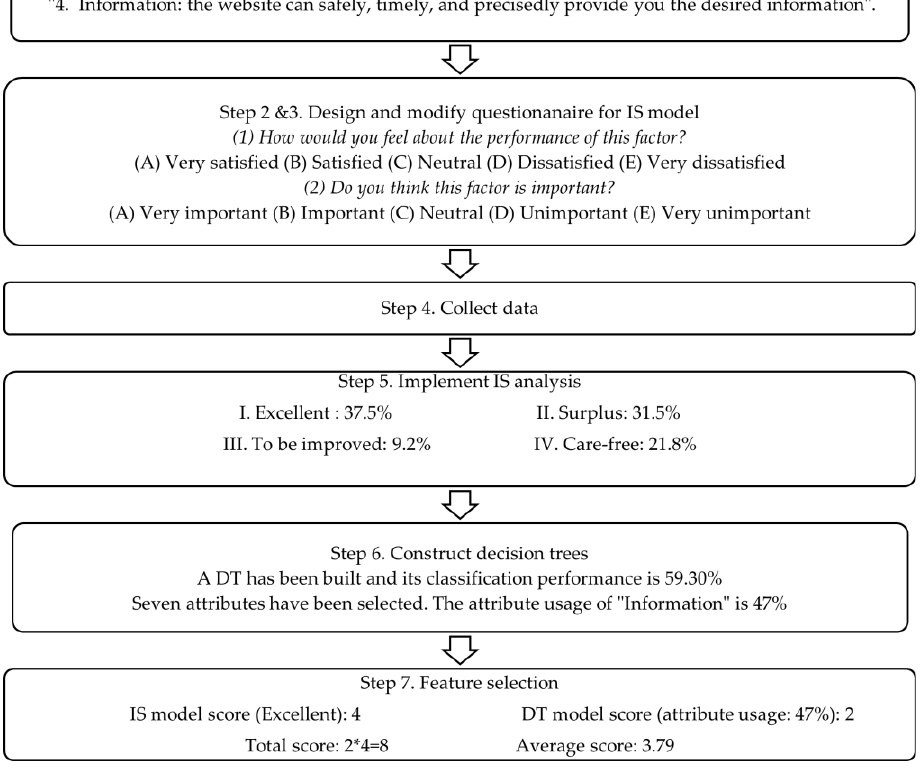
Figure 3. Implemental procedure of the IS-DT proposed method.